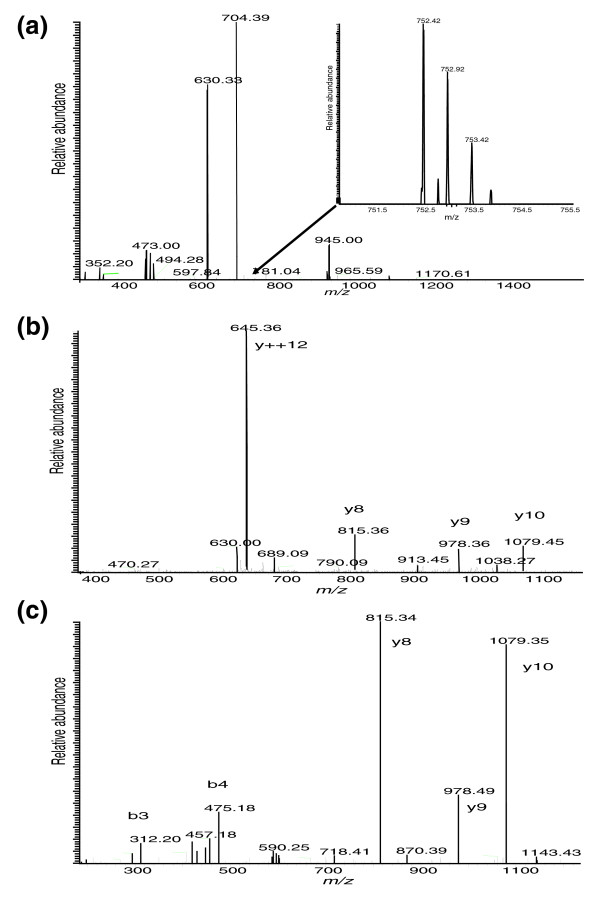
Two consecutive stages of mass spectrometric fragmentation (MS3). (a) The precursor of a peptide LTPITYPQGLAMAK (see insert) was selected for fragmentation from a full scan of mass-to-charge ratio (m/z) range. (b) A fragment of the above, the doubly charged y12 ion, was subsequently fragmented. (c) The characteristic pattern for charged directed fragmentation is observed in MS3 spectra and confirms the identification of the above peptide.